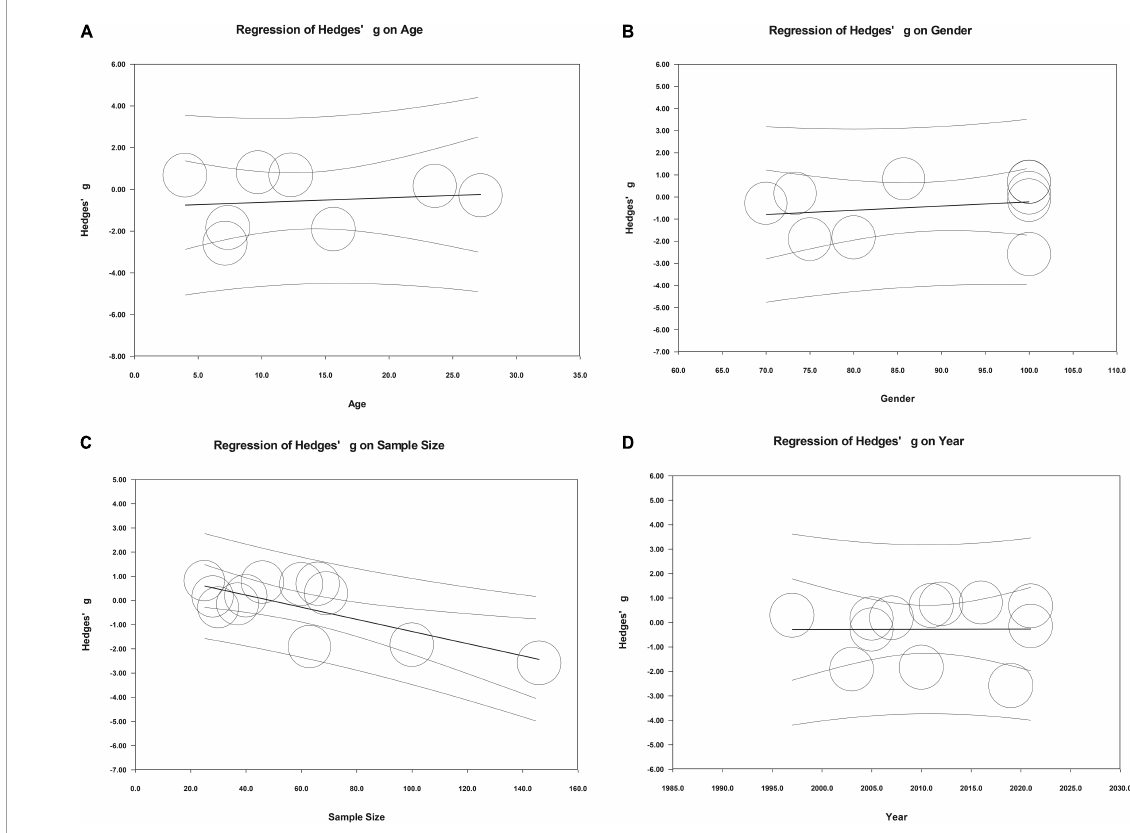
FIGURE7 Meta-regression in all studies.